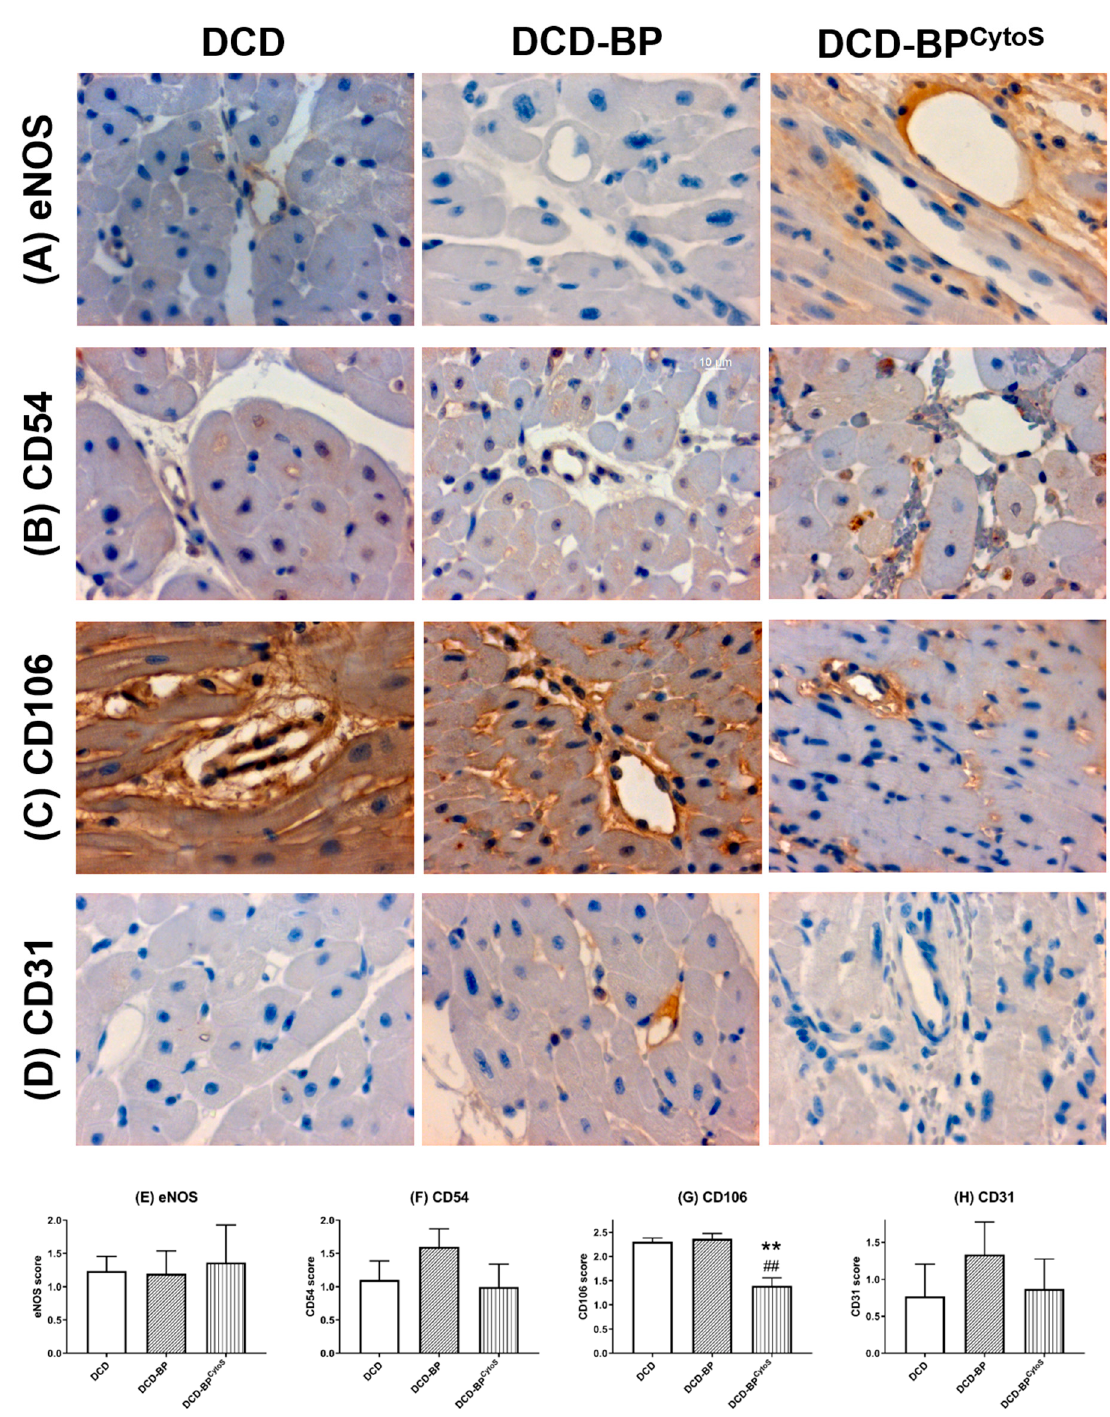
Figure 6. Representative photomicrographs of immunohistochemical staining of injury markers ( A – D ). Semiquantitative analysis of arteriolar immunoreactivity ( E – H ). ** p < 0.001 compared to DCD. ## p < 0.001 compared to DCD-BP. BP: blood perfusion. CD: cluster of differentiation. DCD: donation after circulatory death. BP CytoS : blood perfusion with an integrated cytokine